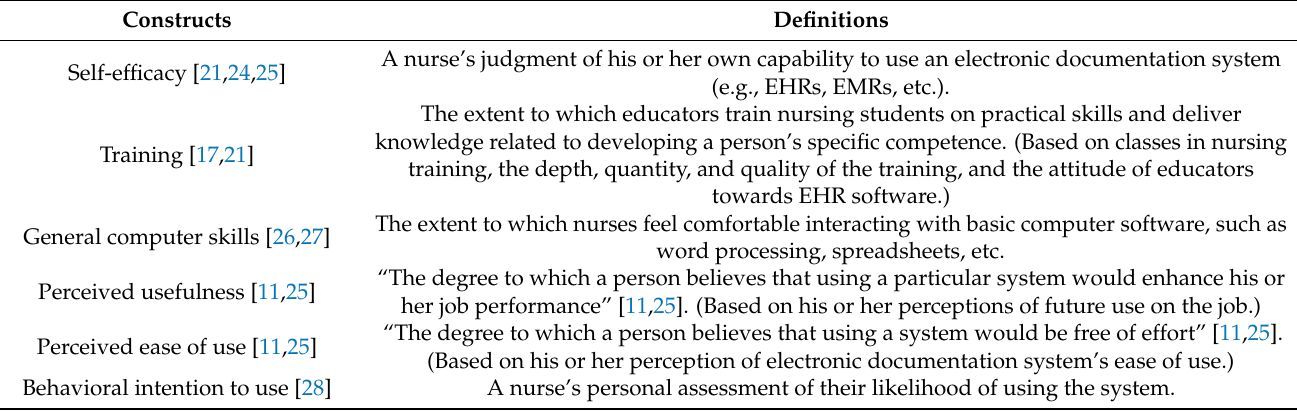
Table 1. Constructs of proposed technology acceptance model (TAM), definitions, and research hypotheses. Constructs Definitions